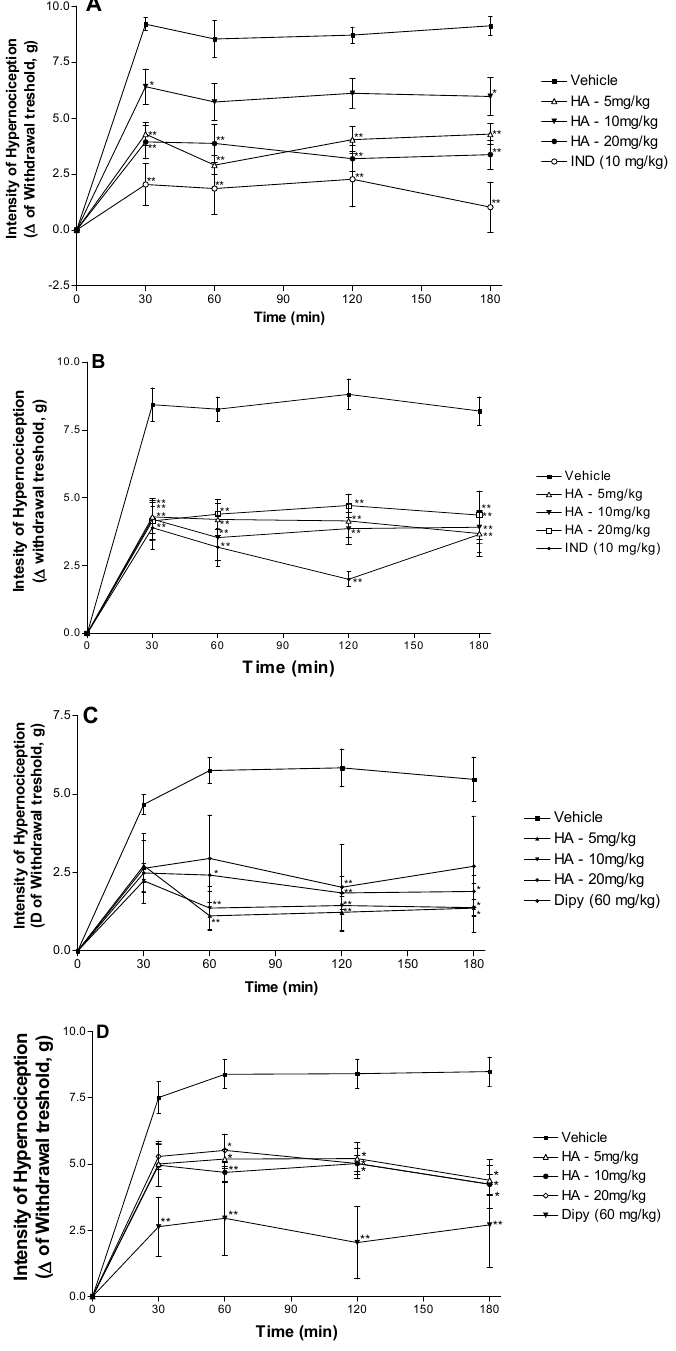
Figure 2. Effect of the acute administration of vehicle, hecogenin acetate (HA, 5, 10 or 20 mg/kg; i.p.) or reference drugs (indomethacin—10 mg/kg; i.p. or dipyrone—60 mg/kg, i.p.) on mechanical hyperalgesia induced by carrageenan ( A ), TNF- α ( B ), dopamine ( C ) or PGE2 ( D ). Each point represents the mean ± SEM of the paw withdrawal threshold (in grams) to tactile stimulation of the ipsilateral hind paw. * p < 0.05, ** p < 0.01 and *** p < 0.001 versus control group (ANOVA followed by Tukey